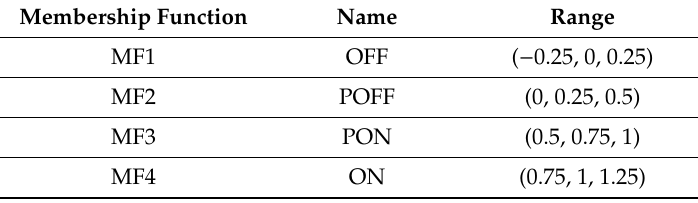
Table 2. Membership functions of fuzzy output (POFF and PON means probably off and probably on).